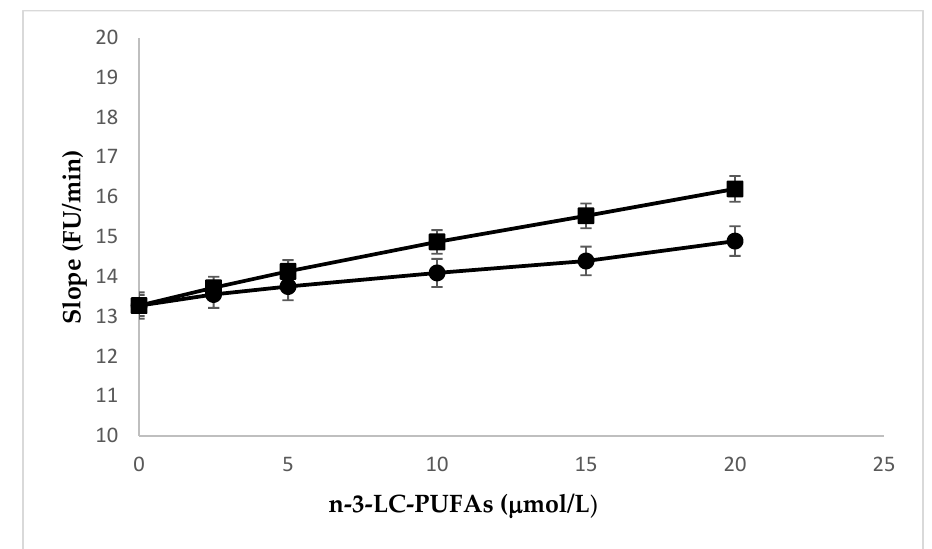
Figure 4. Effect of the incubation with increasing amounts of EPA (●) and DHA ( ∎ ) enrichment on peroxidation kinetics of HMEC. Experiments were performed in triplicate. Data are expressed as mean ± SD of replicates. Pearson’s r = 0.9921, p < 0.0001 and Pearson’s r = 0.9973, p < 0.0001; EPA and DHA, respectively. Slope EPA vs. slope DHA p ≤ 0.0001.